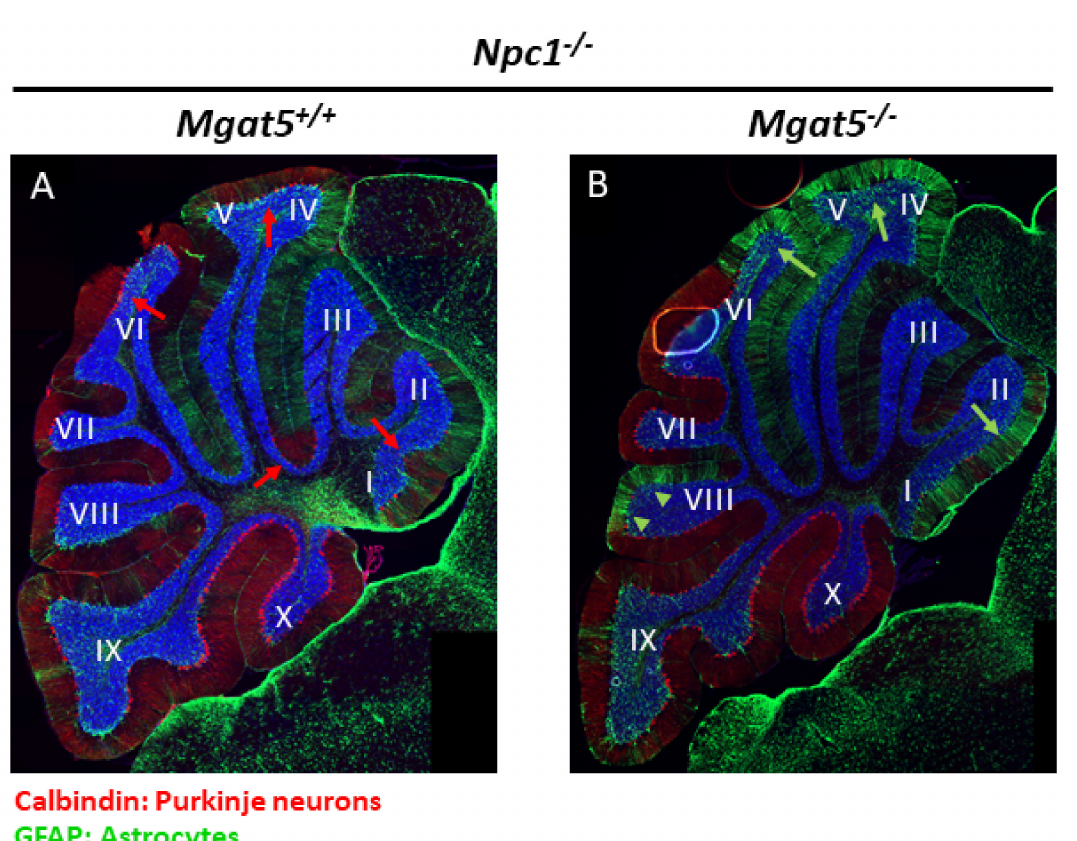
Figure 4. Immunofluorescence analysis of Purkinje neurons and astrocytes in cerebellar sections of mutant mice. The cerebella of mutant mice (7 weeks old) were fixed, sectioned, and stained for